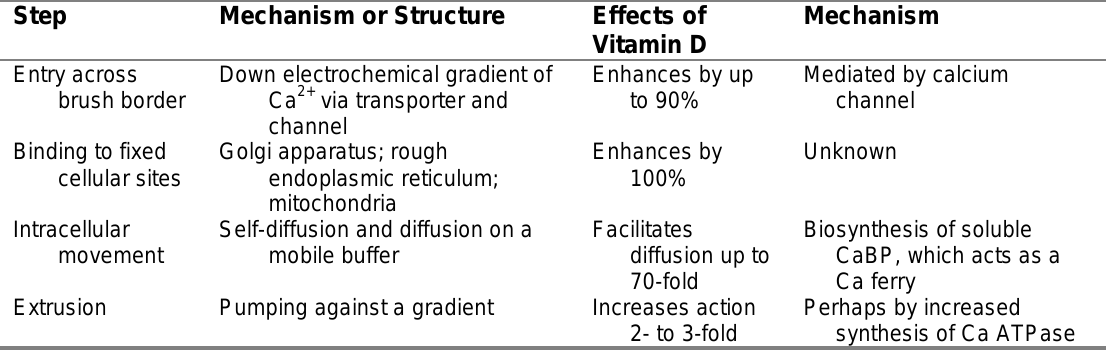
Effects of Vitamin D on Transcellular Calcium Transport in